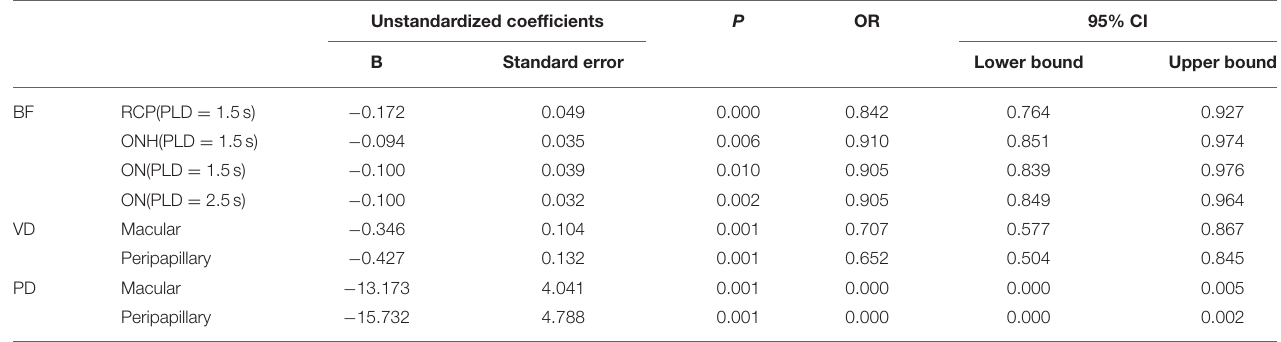
TABLE 4 | Logistic regression analysis of factors associated with